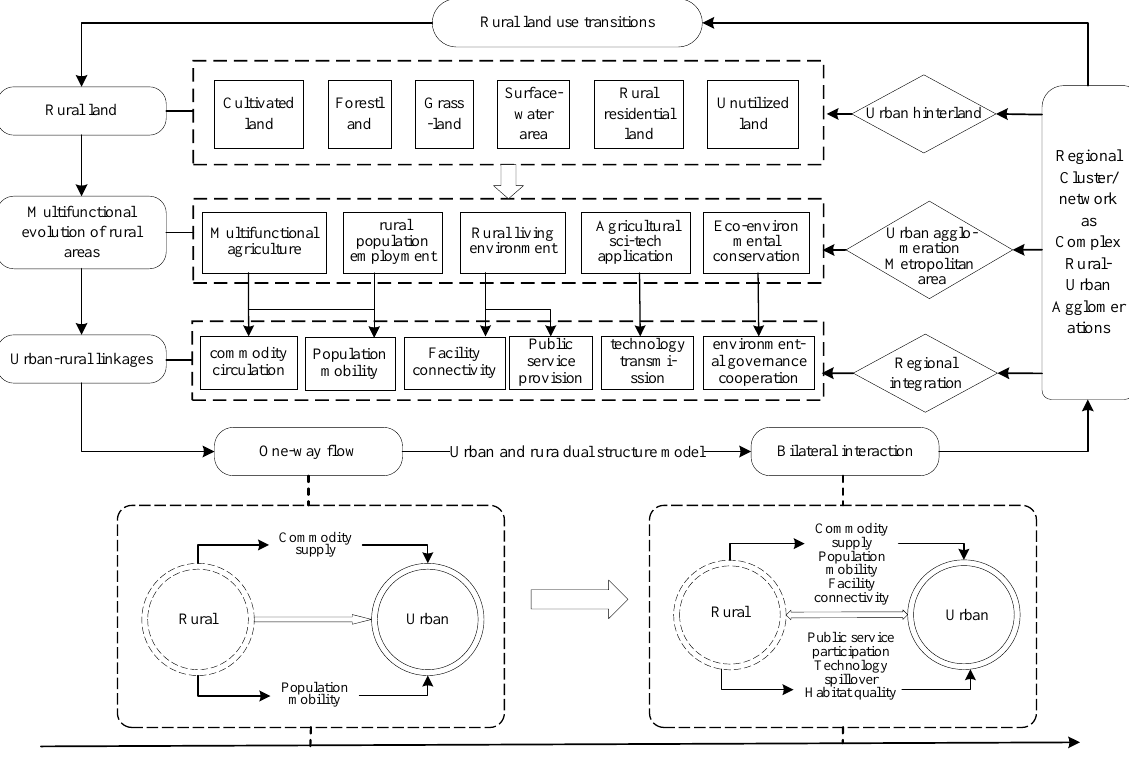
Figure 1. Association mechanism between rural land use transition and URID.